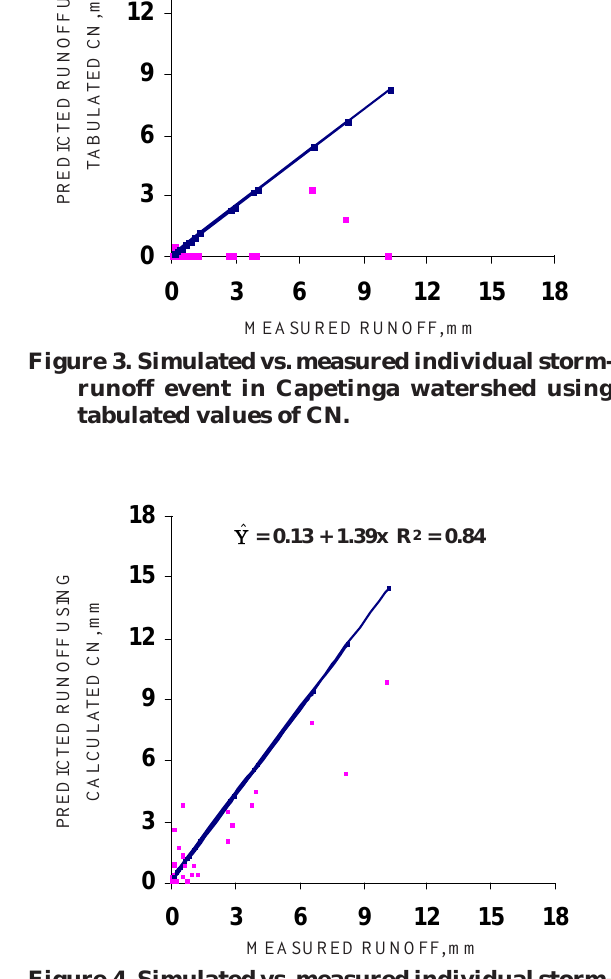
Figure 4. Simulated vs. measured individual storm- runoff event in Capetinga watershed using calculated values of CN.